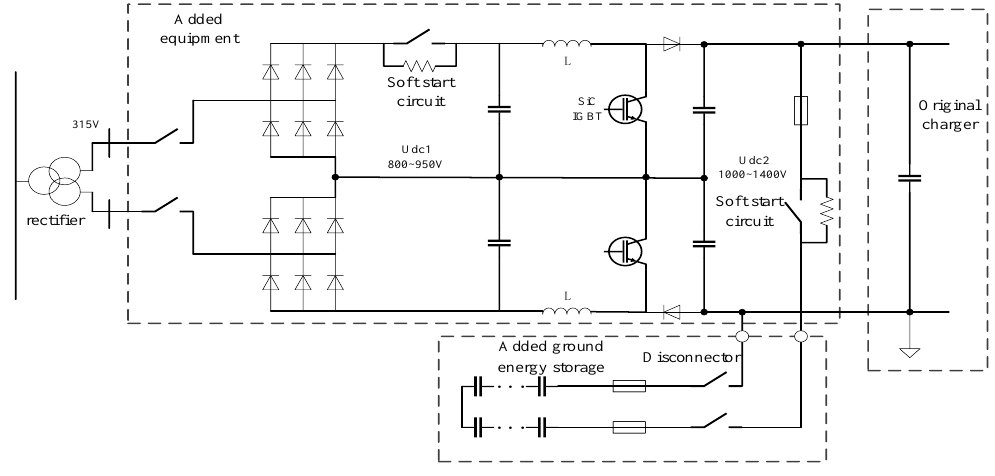
Figure 2. Co-charging topology for supercapacitor energy storage. (1) The grid voltage of the distribution network is lowered; 10 kV or 0.4 kV power supply can be used for access. Transformer capacity is reduced. During the operation period, the transformer is able to work under rated conditions, regardless of whether the vehicles are charged or